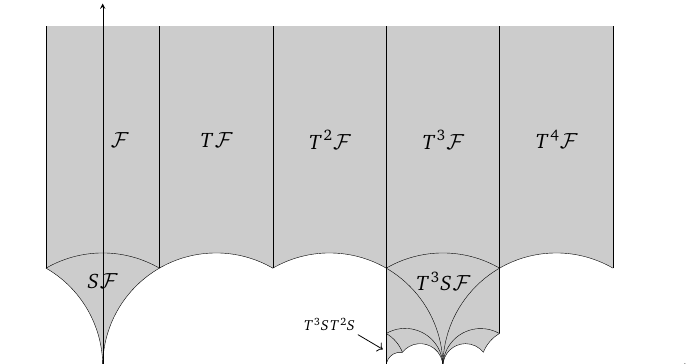
) cusps at τ = 0, 5 , I , I , I 1 1 5 5